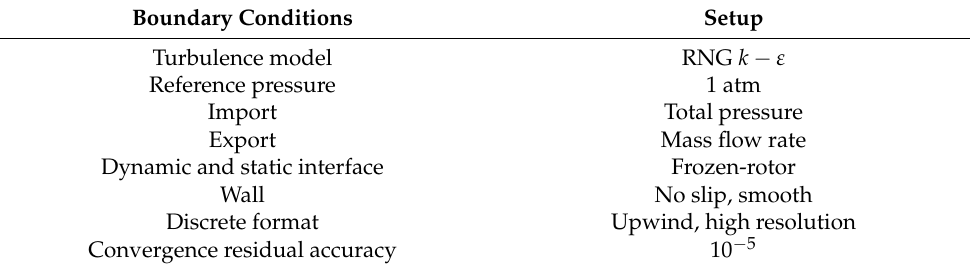
Table 3. Correlating setting of numerical